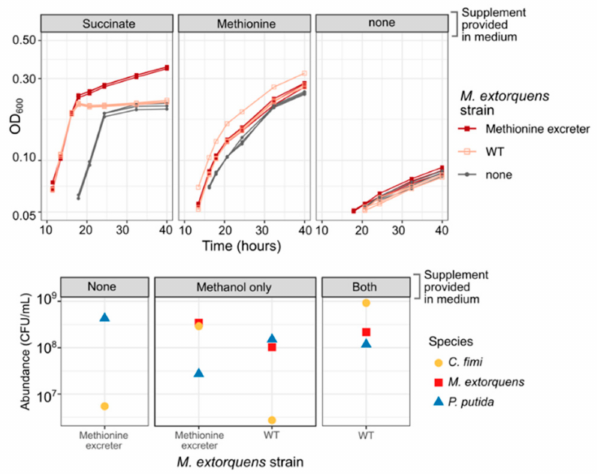
Figure 9. A methionine-overproducing strain of M. extorquens can support the growth of C. fimi without the addition of methionine to the medium. Top: growth curves of C. fimi with different strains of M. extorquens (symbols), on MP medium with glucose and supplements (panels). Without succinate, M. extorquens growth is negligible. For C. fimi alone, growth with methionine is much greater than without. However, when succinate is present to enable M. extorquens growth, the culture of C. fimi + the methionine excreter reaches substantially higher growth than by C. fimi + WT M. extorquens , suggesting a benefit to C. fimi from the methionine. Bottom: colony counts of each species (symbols) from the endpoint of an experiment in which the three-species consortium was grown on Model Lignocellulose medium with either of the two strains of M. extorquens ( x -axis), and supplemented with either nothing, methanol to support M. extorquens growth, or both methanol and methionine (panels). C. fimi grows only when methionine is present or when both methanol and the methionine-excreting M. extorquens strain are present. P. putida does not show the same reliance on methionine or M. extorquens